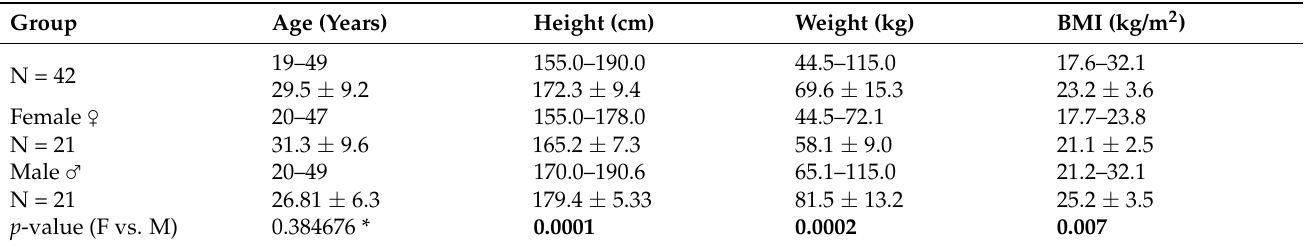
Table 1. Data on demographic and anthropometric characteristics of subjects included in research group. Ranges, mean values, and standard deviations are